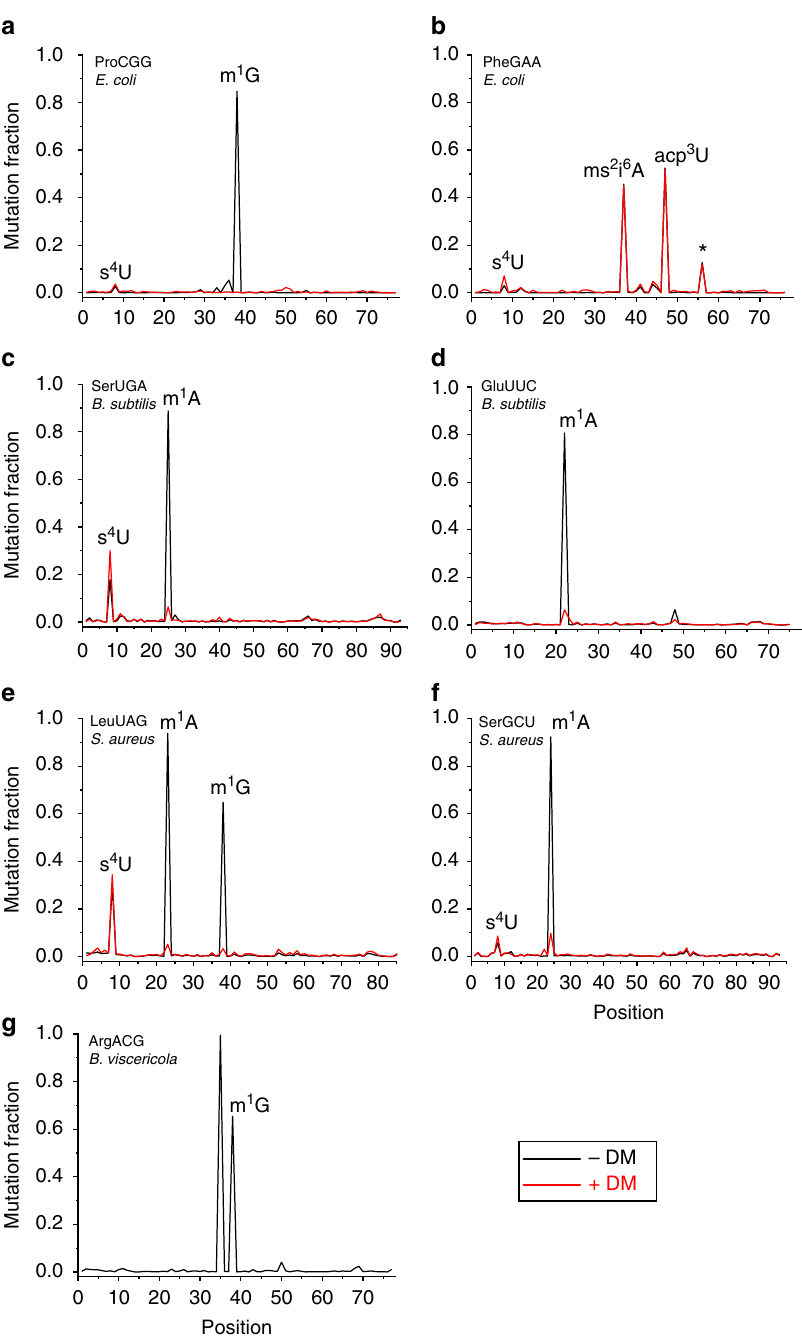
Fig. 1 tRNA modi fi cations of bacterial cultures. Red and black lines show mutation fractions in representative tRNA sequences with ( + DM) and without (-DM) demethylase treatment, respectively. a E. coli tRNA Pro (CGG) shows m 1 G37 and s 4 U8. b E. coli tRNA Phe (GAA) shows acp 3 U47, ms 2 i 6 A37 and s 4 U8. The additional peak denoted by asterisk (*) may represent an unknown modi fi cation. c B. subtilis tRNA Ser (UGA) shows m 1 A22, and s 4 U8. d B. subtilis tRNA Glu (UUC) shows m 1 A22. e S. aureus tRNA Leu (UAG) shows m 1 G37, m 1 A22 and s 4 U8. f S. aureus tRNA Ser (GCU) shows m 1 A22 and s 4 U8. g B. viscericola tRNA Arg (ACG) shows m 1 G37 and